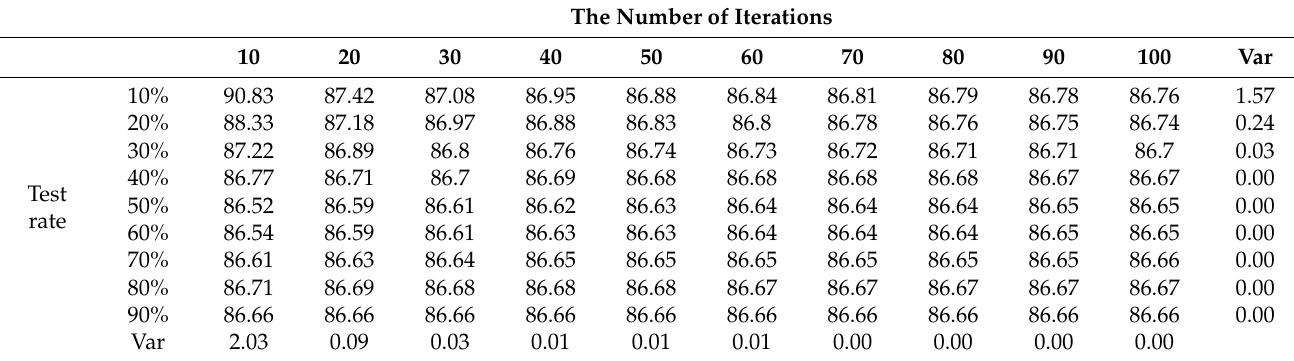
Table 5. The diagnosis accuracy of the PMDCM based on GNB classifier. The Number of Iterations